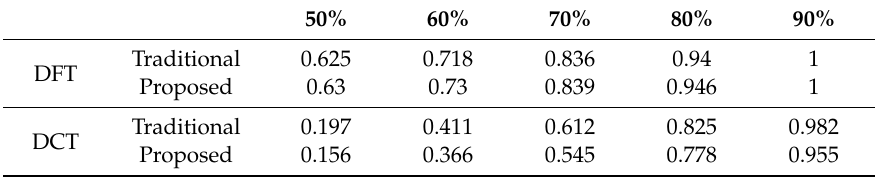
Table 1. Normalized root mean square error (RMSE) of results of envelope detection. 50% 60% 70%